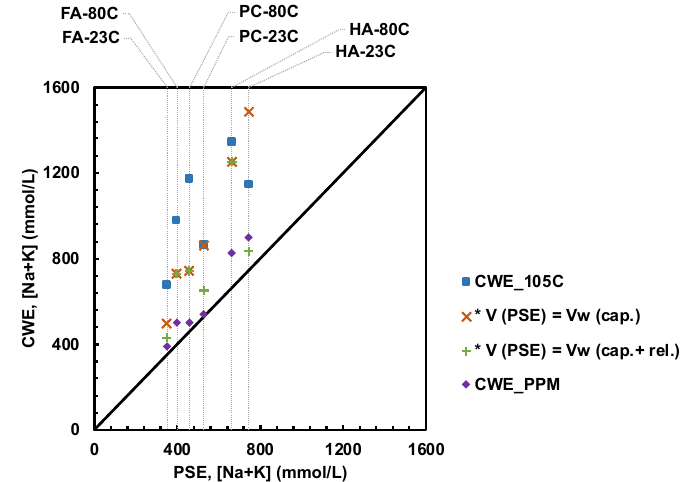
Figure 3. Comparison of total alkali concentrations from PSE to CWE using various approaches for adjusting concentrations. Vertical lines and labels identify samples. Cases marked with an asterisk (*) are alternatives to Eq. 10 (used to calculate CWE_PPM) and are only included for discussion